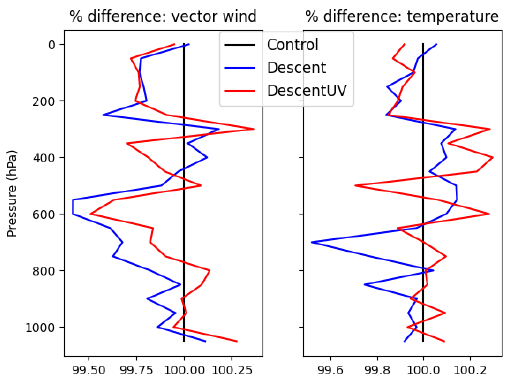
Figure 24. The effect of the assimilation of all descent data (wind, temperature and humidity; blue line) or just descent winds (red line) for the period from 20 January to 20 April 2020. Results are shown for temperature and the vector wind fit of 12h forecasts to European radiosonde ascents, normalised by the fit of the control forecasts (so values less than 100% indicate improved